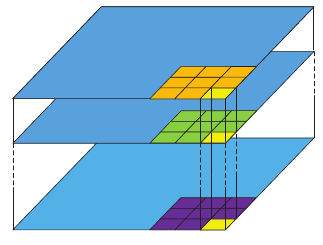
Figure 6. Depthwise separable convolution.